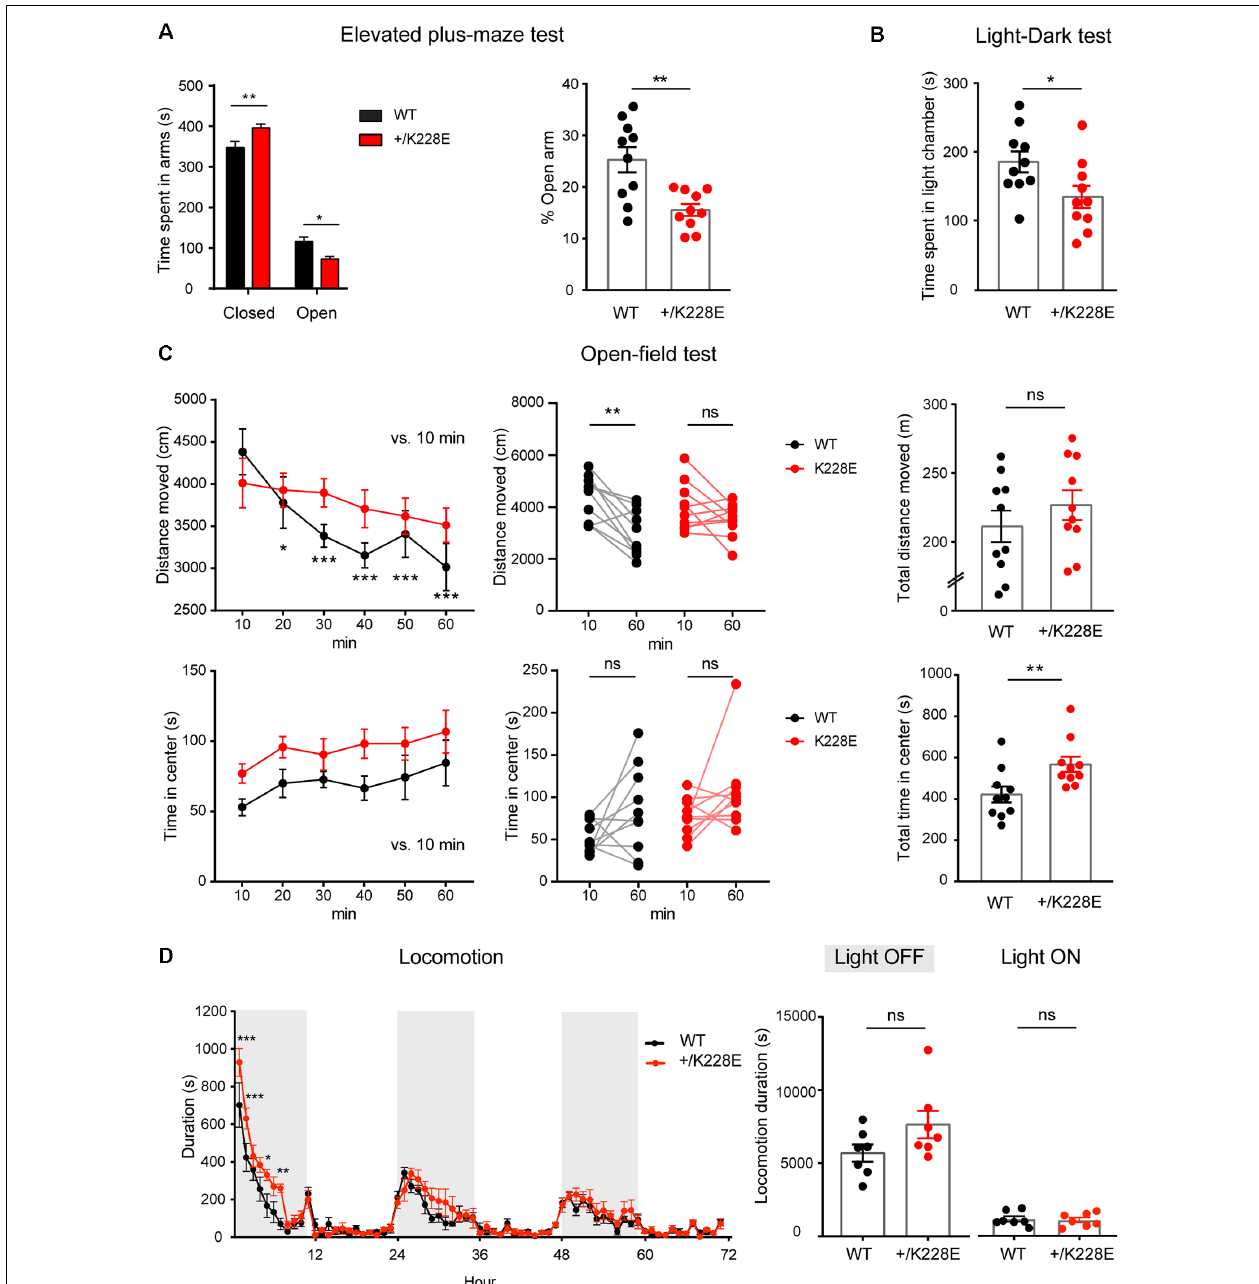
FIGURE 8 | Altered anxiety-like behavior and modestly increased locomotor activity in Tbr1 + / K228E mice. (A) Enhanced anxiety-like behavior in Tbr1 + / K228E mice (3 months; male) in the elevated plus-maze test, as shown by time (total and %) spent in open/closed arms. n = 10 mice for WT and HT, ∗ P < 0.05, ∗∗ P < 0.01, two-way ANOVA with Sidak’s multiple comparison test (total time) and Mann–Whitney test (% time). (B) Enhanced anxiety-like behavior in Tbr1 + / K228E mice (3 months; male) in the light-dark test, as shown by time spent in the light chamber. n = 10 mice for WT and HT, ∗ P < 0.05, Mann–Whitney test. (C) Normal locomotor activity but decreased habituation in Tbr1 + / K228E mice (3 months; male) in the open-field test. Note that the time spent in the center region of the open-field arena is abnormally increased, indicative of anxiolytic-like behavior, although the suppressed habitation to the environment, indicated by the increasing difference in the distance moved across the 10-min sections and the distance moved during the first and last 10 mins, might complicate this interpretation. n = 10 mice for WT and HT, ∗ P < 0.05, ∗∗ P < 0.01, ∗∗∗ P < 0.001, ns: not significant, repeated measures two-way ANOVA with Dunnett’s multiple comparisons test (Distance moved over 60 min, Center time over 60 min), Wilcoxon matched-pairs signed-rank test (10 min vs. 60 min), Student’s t -test (total distance moved), and Mann–Whitney test (total time in center). (D) Modestly increased locomotor activity in Tbr1 + / K228E mice (3 months; male) in Laboras cages. Note that hyperactivity is mainly observed during the first ∼ 6 h of the light-off period on day 1. n = 7 mice for WT and HT, ∗ P < 0.05, ∗∗ P < 0.01, ∗∗∗ P < 0.001, ns: not significant, two-way repeated-measures ANOVA with Sidak’s multiple comparisons test and Mann–Whitney test (light-on/off).